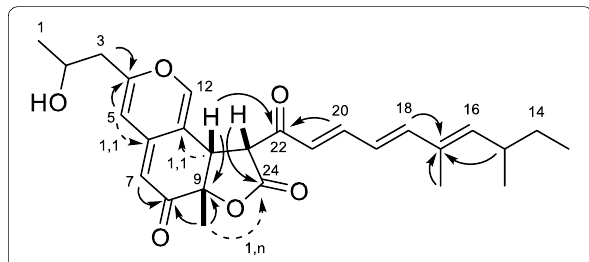
Fig. 2 Structure and key HMBC (plain arrows) and ADEQUATE (dashed arrows) correlations for sassafrin E ( 1 )